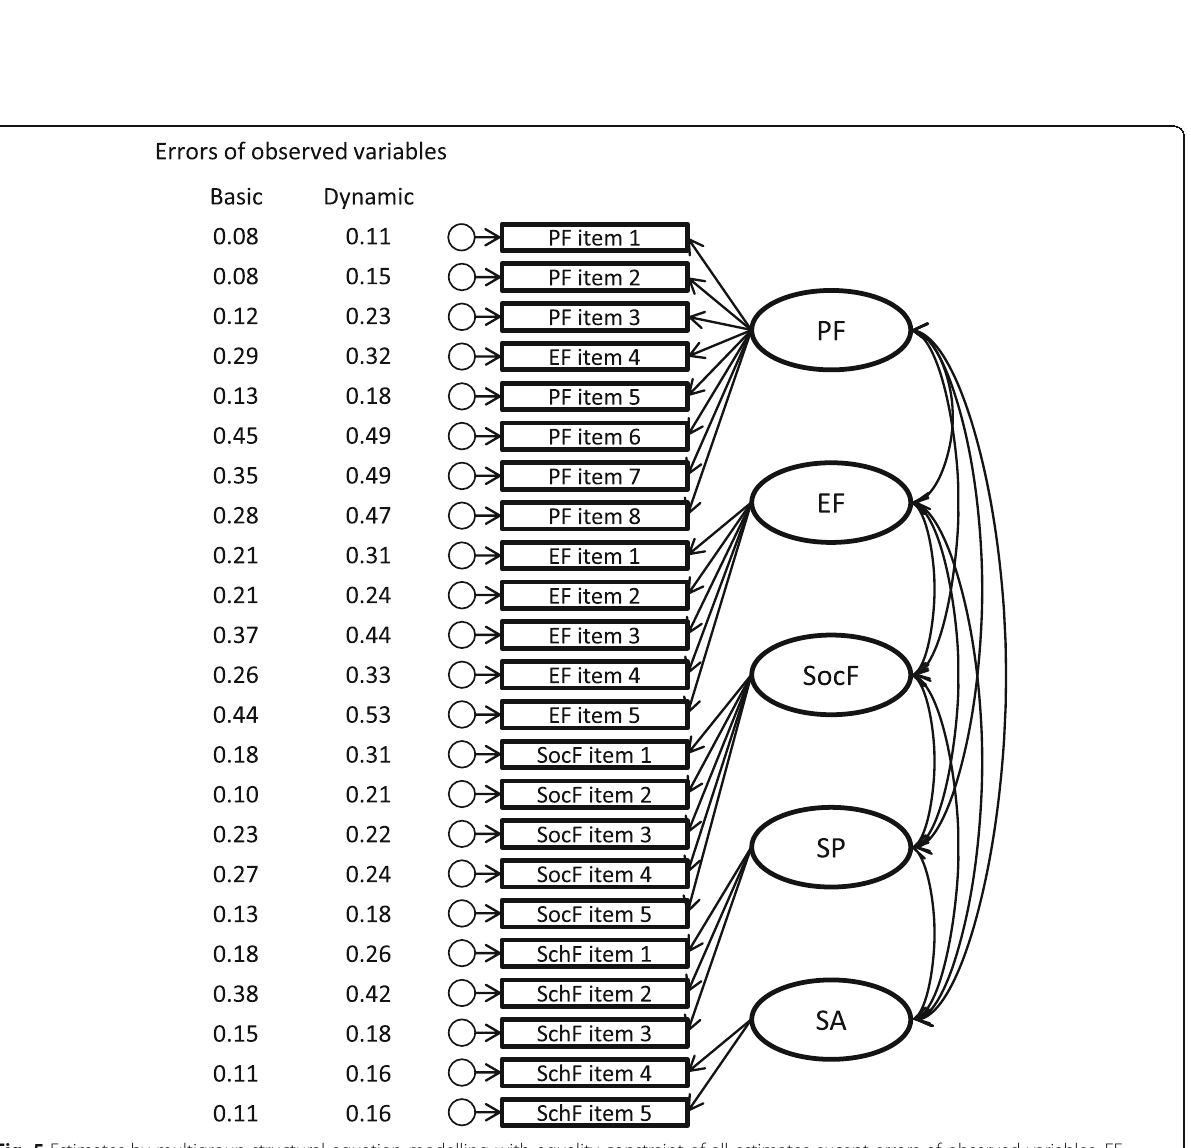
Fig. 5 Estimates by multigroup structural equation modelling with equality constraint of all estimates except errors of observed variables. EF: Emotional Functioning. PF: Physical Functioning. SA: School Absenteeism. SchF: School Functioning. SocF: Social Functioning. SP: School Presenteeism. In one case, the multigroup structural equation model showed that the basic and dynamic ePedsQL had similar (equally constrained) structure (shown in this figure) and metrics (path coefficient, intercept, variance and covariance) but not errors (variances) of the observed variables (each item). Accordingly, each error of the observed variables was estimated as shown in the figure by